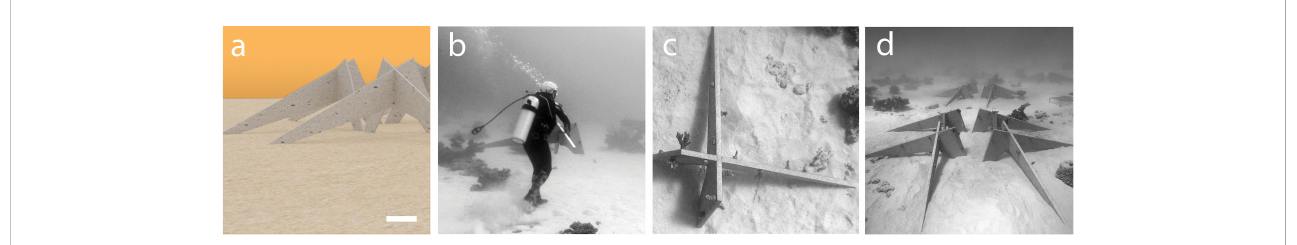
FIGURE 4 Maritechture ™ Coral pods (patent pending, U.S. Patent Application No. 62/954,435| Filed December 28, 2019). (A) Illustration of coral pod design. White bar indicates 20 cm in width. (B) Diver placing coral pod underwater. (C) Coral pod with coral fragments in situ . (D) Arrangement of coral